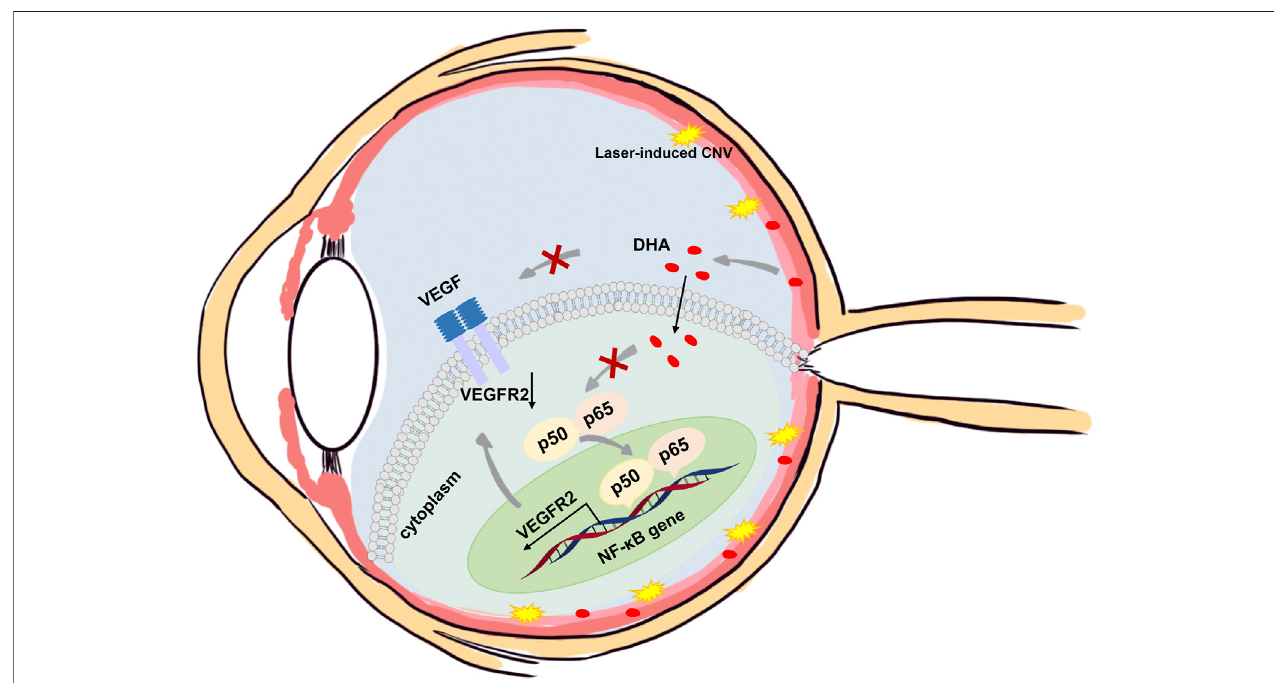
FIGURE 7 | Schematic illustration of the mechanisms ofthe anti-CNV effects ofDHA. In addition to the downregulation ofVEGF expression, DHA inhibits VEGFR2 expression and angiogenesis through suppression of the NF- κ B pathway.